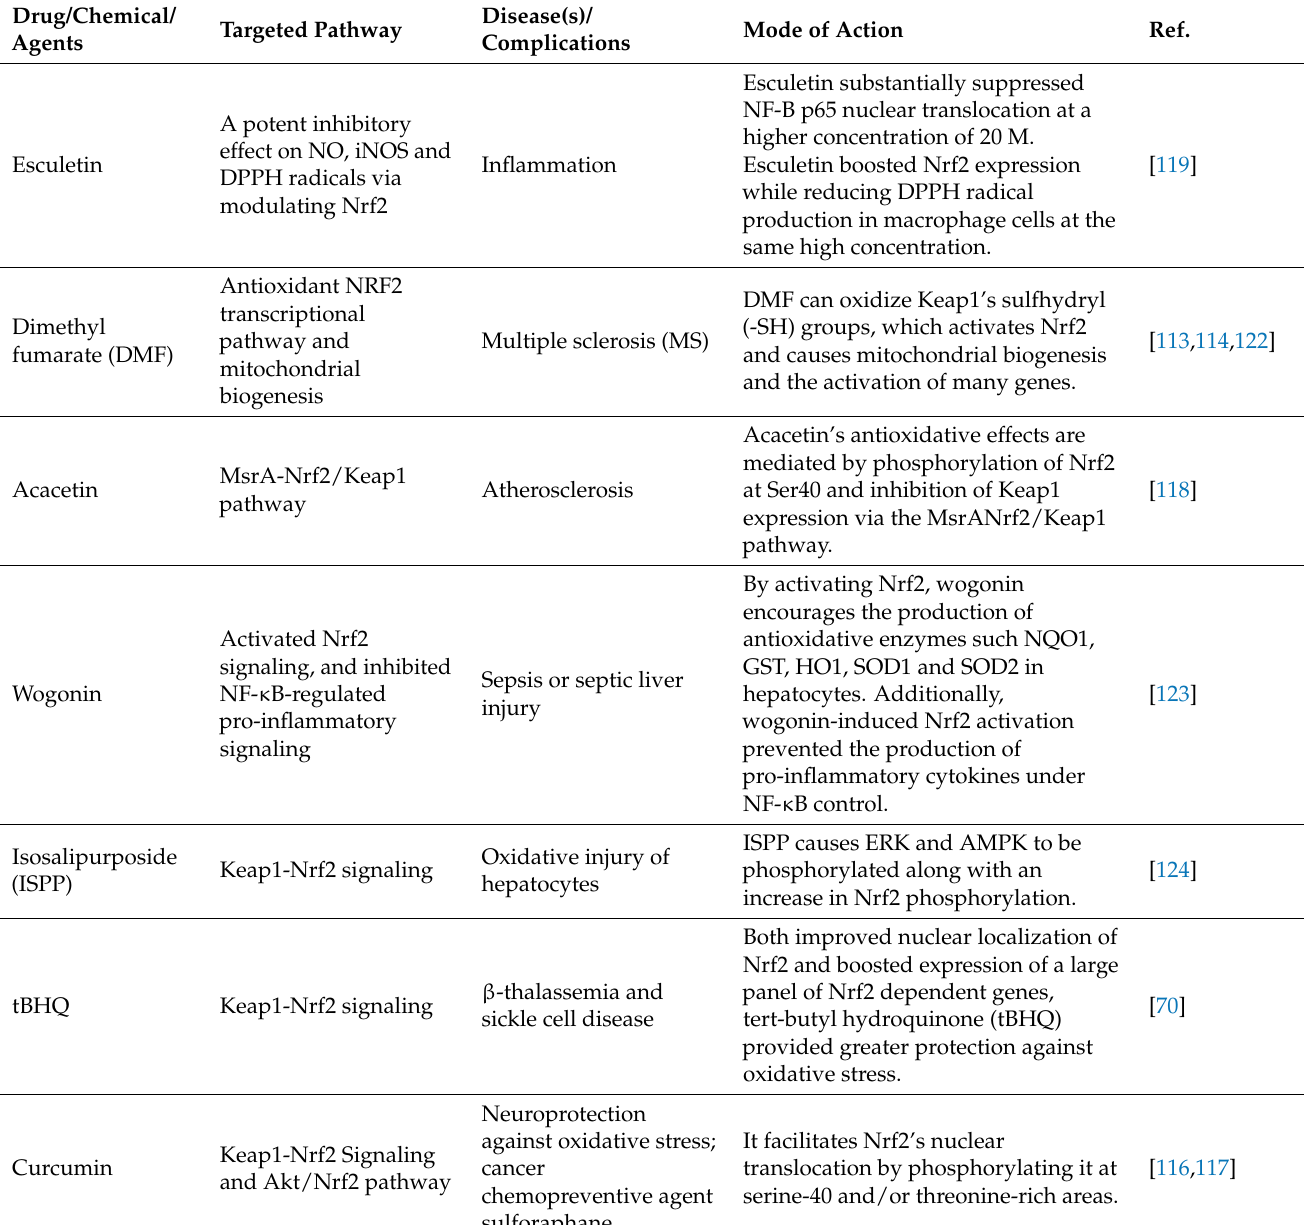
Table 1. NRF2-Keap1 modulating drugs, targeted pathways and their mode of action in response to oxidative